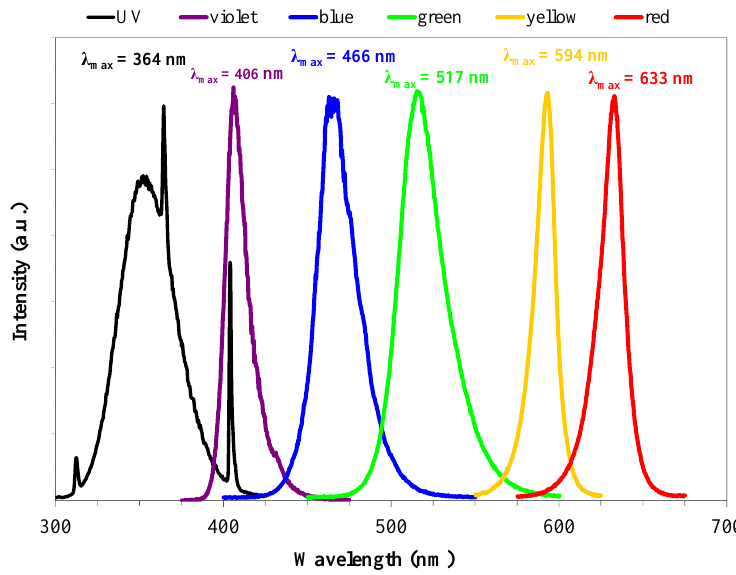
Figure 5. Emission spectra of UV-A fluorescence tubes and LED strips.